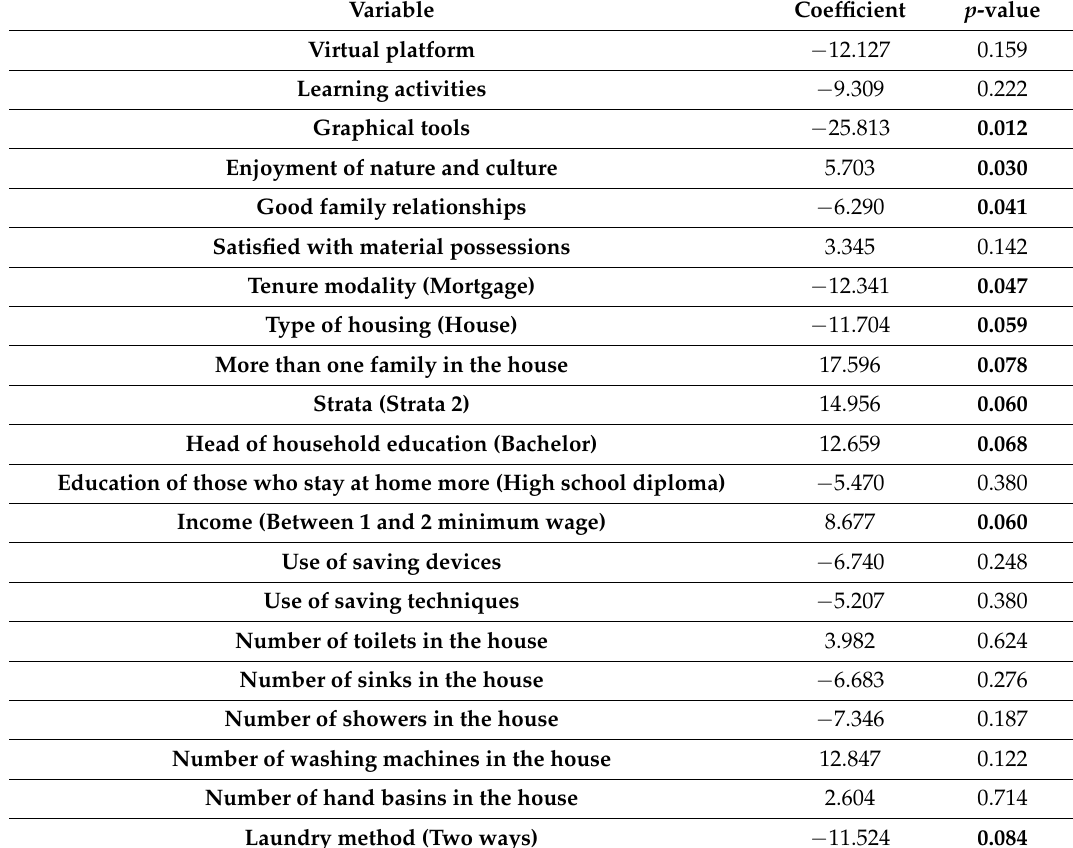
Table 2. Coefficients and p -value for main variables in the